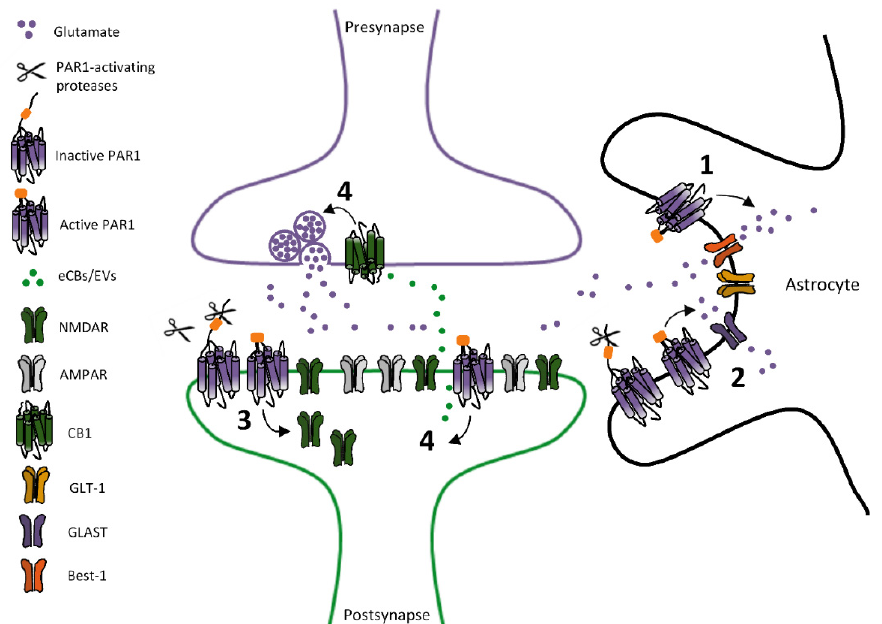
Figure 2. PAR1-dependent modulation of glutamatergic transmission. Scheme depicting proposed mechanisms underlying PAR1-induced regulation of glutamatergic transmission. They include (1) PAR1 activation fostering glutamate release from astrocytes and diffusion through Bestrophin- 1 (Best-1) channels. (2) Astrocytic PAR1 activation modulating glutamate reuptake by glutamate transporter 1 (GLT-1) or glutamate aspartate transporter (GLAST). (3) PAR1-dependent endocytosis of NMDARs. (4) PAR1-induced endocannabinoids (eCBs)/endovanilloids (EVs)-dependent reduction of glutamate